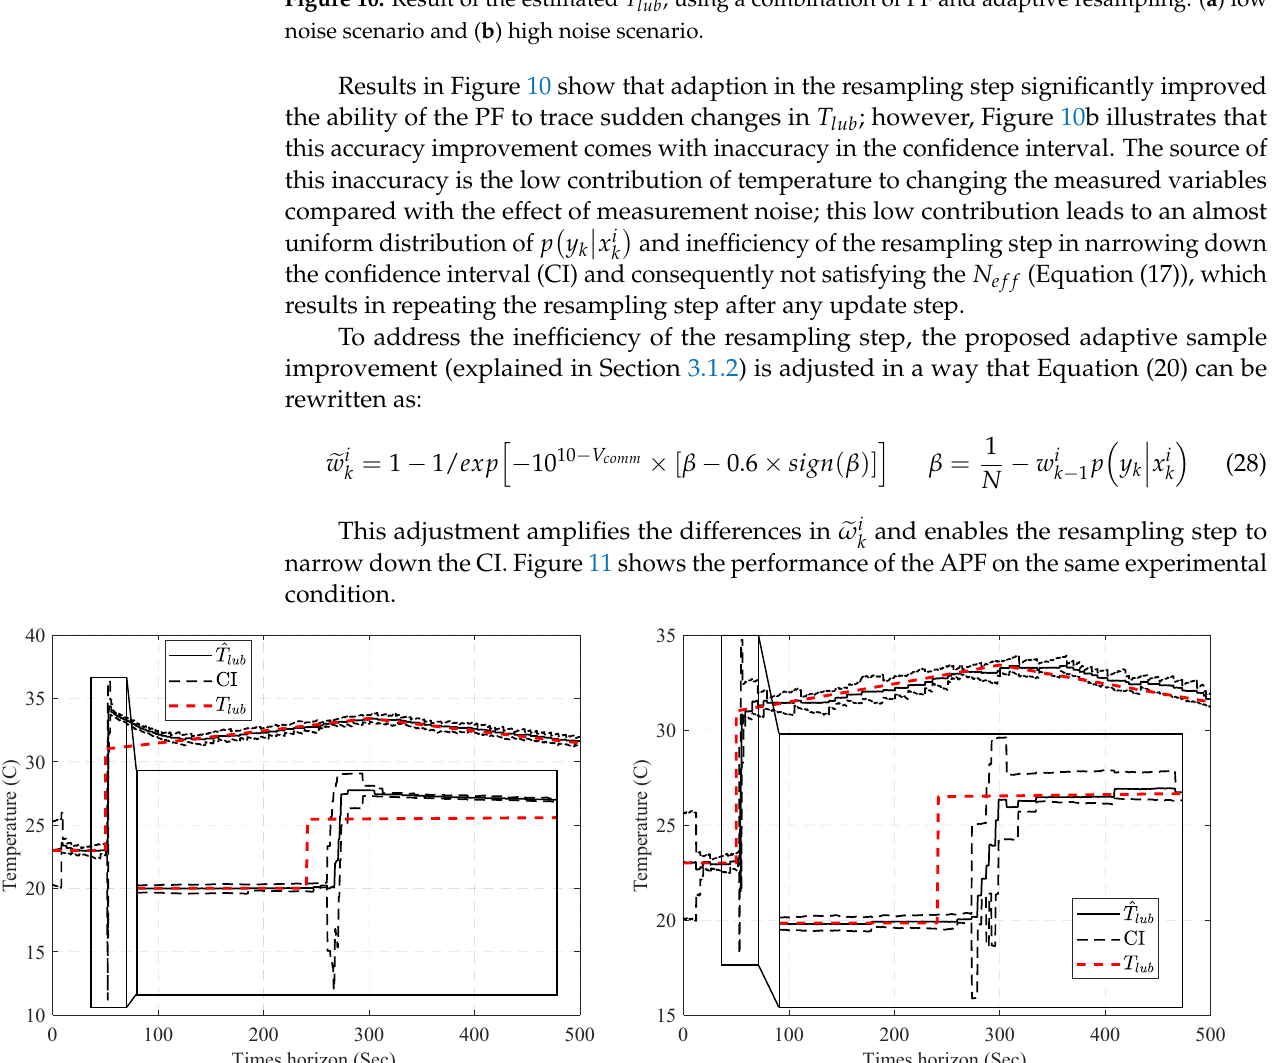
Figure 10. Result of the estimated T lub , using a combination of PF and adaptive resampling: ( a ) low noise scenario and ( b ) high noise scenario.